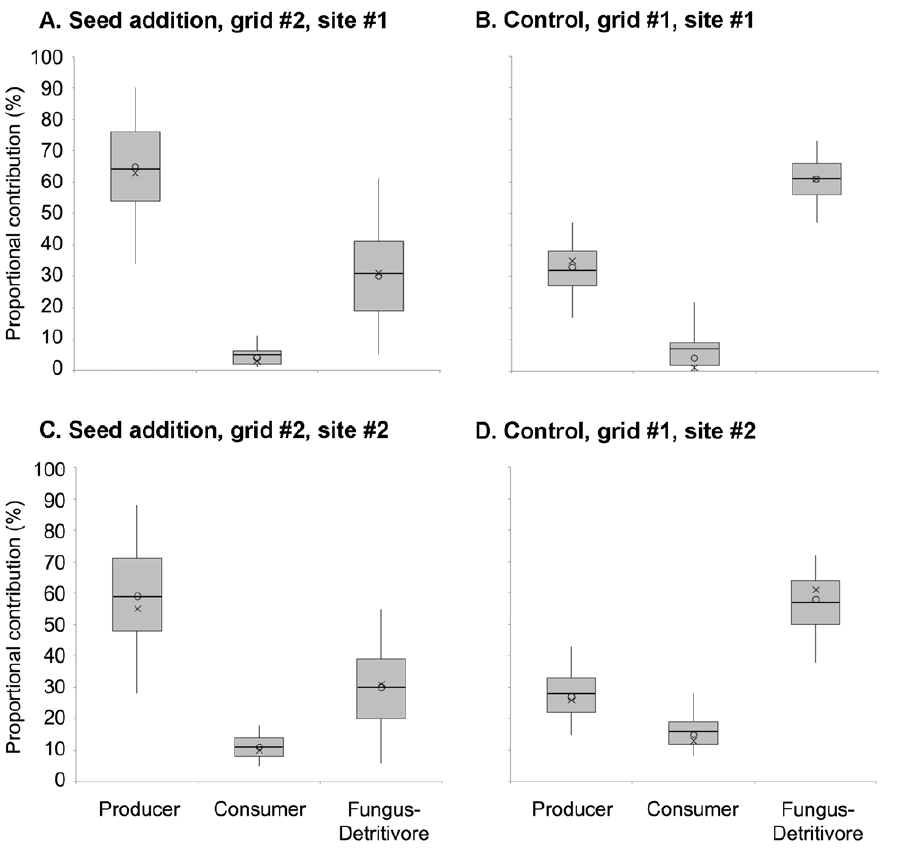
Figure 3. The producer, consumer, and fungus-detritivore contributions to the mouse diets in the seed mast experiment. The seed addition grids were plotted on the left and the control grids on the right for the first site (A, B) and the second site (C, D). The probability distributions of the plants and millet seeds were combined to represent the producer contributions in the seed addition grids (A, C). The lines, circles, and crosses denote the means, medians, and modes. The boxes and whiskers denote the 25–75th and 5–95th percentiles, respectively.